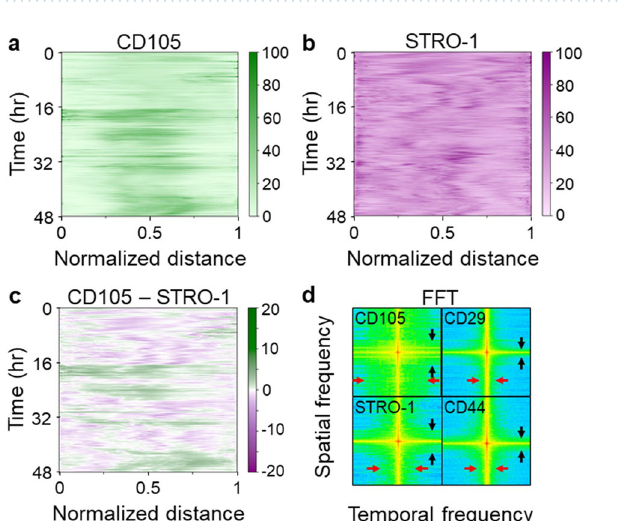
Figure 4. Spatial-temporal fluctuations of MSC marker expression. ( a ) Predicted time-lapse composite snapshots of a single cell at 0, 16, 32 and 48 h (left to right). ( b ) Total protein expression fluctuation for 4 surface markers (CD105, CD29, STRO-1, and CD44) of the predicted 48-h time-lapse video. Graph was created by using OriginLab version 2019. ( c ) Pairwise cross correlation between the tested markers. We calculated both the overall correlation (dark grey) and the fluctuation correlation (light grey) where the line thickness denotes the correlation magnitude. The fluctuation correlation (light grey) calculated using the single cell data is significantly lower than the overall correlation determined using all 500 cells, indicating remarkable stochasticity in the gene expression fluctuation. ( d ) Averaged autocorrelation functions (ACF) for all four tested markers exhibit a similar exponential decay. Inset shows the ACF decay rates, which are roughly the correlation time of them. ( d ) was created by using OriginLab version 2019.